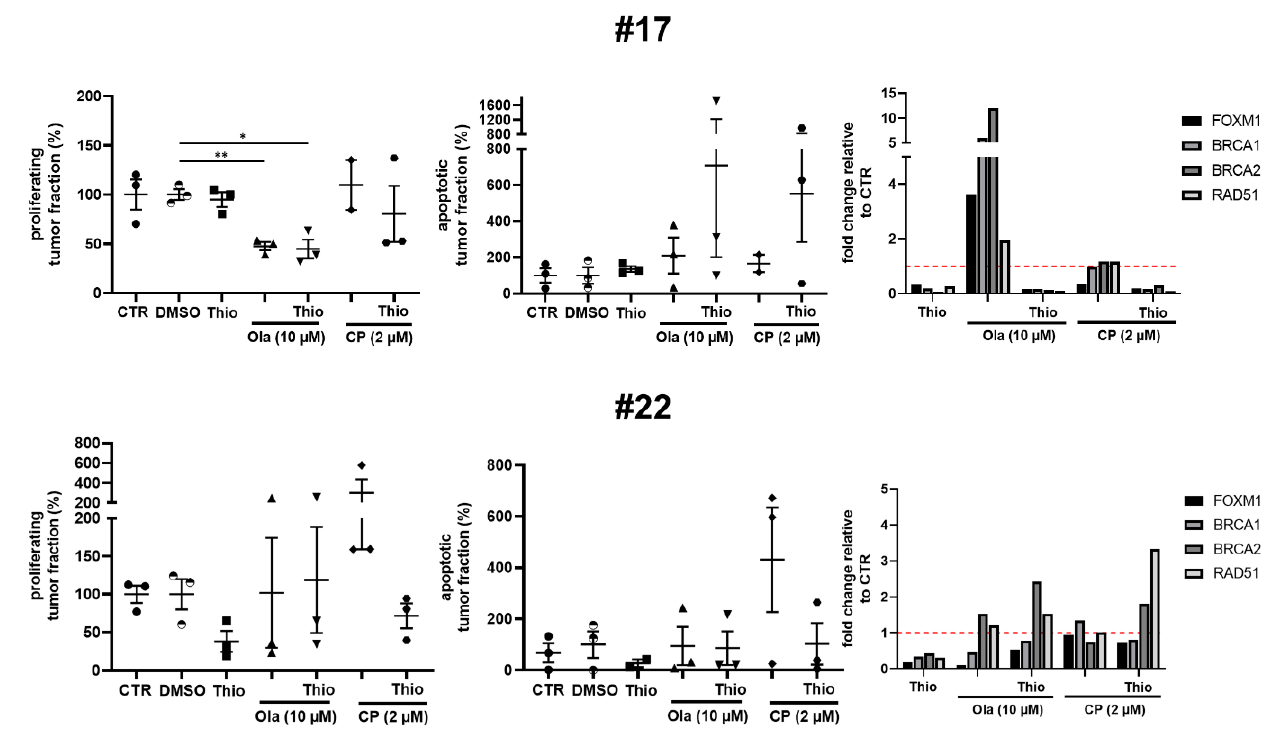
Figure 5. Regulation of the transcription factor FOXM1 and its downstream targets by application of thiostrepton, olaparib and carboplatin. Case #17 showed no beneficial effect of combination treatment (Thio + Ola/Thio + CP) in proliferation rates. Apoptosis was heterogeneously increased in the slice triplicates, showing an additive effect of thiostrepton. While olaparib strongly upregulated FOXM1, BRCA1/2 and RAD51, thiostrepton addition could overcome compensatory homologous recombination (HR) gene regulation. Similar findings could be seen for carboplatin (CP). #22 neither showed treatment response to Thio + Ola/Thio + CP in the quantification of proliferation or apoptosis, nor in mRNA expression. Error bars represent SEM. * p < 0.05, ** p < 0.005 (student’s t -test). Case #17 (Figure 5) shows a significant inhibition of proliferation to about 48 ± 4.3% (mean ± SEM) with olaparib as monotherapy compared to the vehicle control. The same